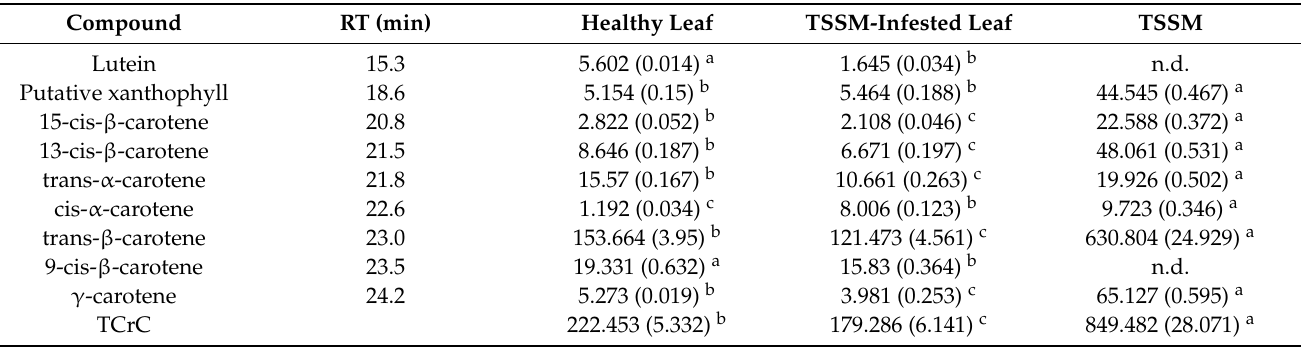
Table 2 . Quantification of carotenoids in Lima bean healthy and TSSM-infested leaves and in TSSM. Values are reported as mean (±standard deviation) values of at least three biological replicates. For each raw, different letters indicate significant differences ( P ≤ 0.05). For further statistical information, see Supplementary Table S2.